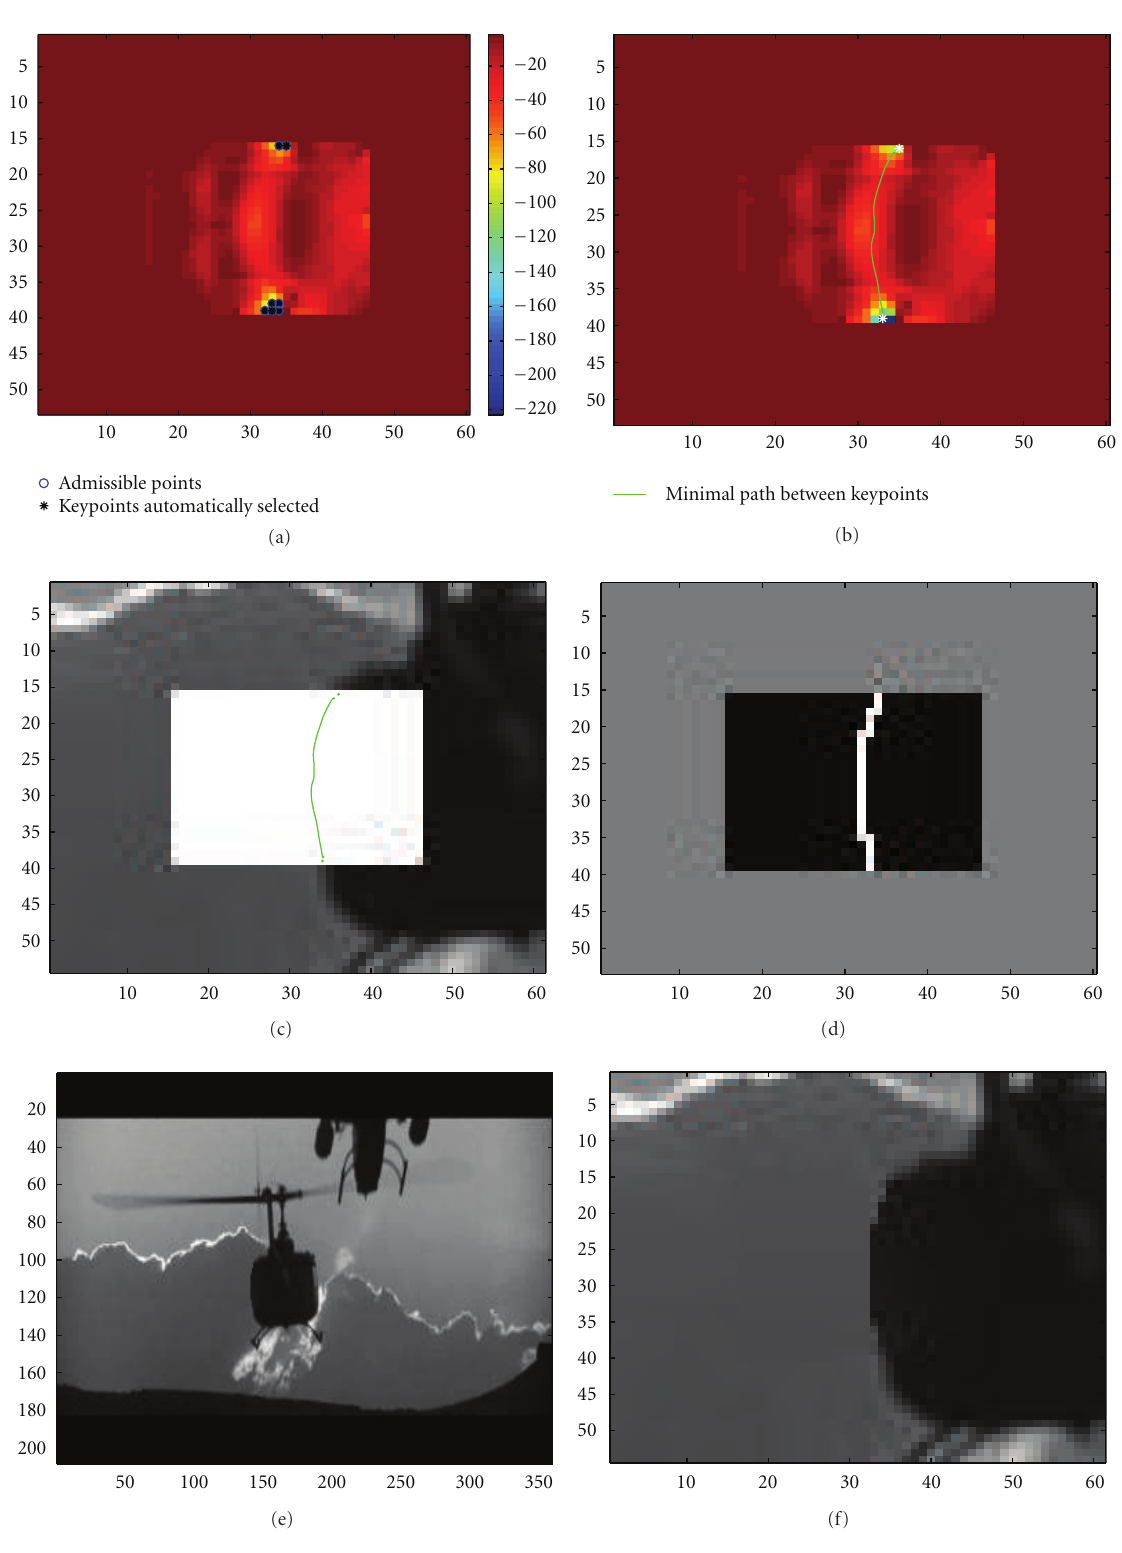
Figure 11: (a) Admissible set of keypoints and selected keypoints on the topological gradient; (b) Minimal path between the keypoints represented on the topological gradient; (c) Minimal path between the keypoints represented on the occluded image; (d) Corresponding identified missing edge in white; (e) Inpainted image using the fast marching algorithm for closing the contours identified by the topological gradient in the hidden part of the image; (f) Zoom of